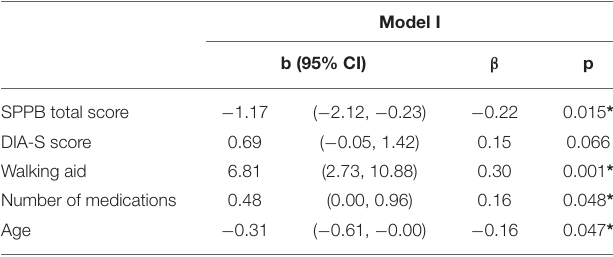
TABLE 3 | Multiple Regression Analyses including SPPB total score with FES-I score as dependent